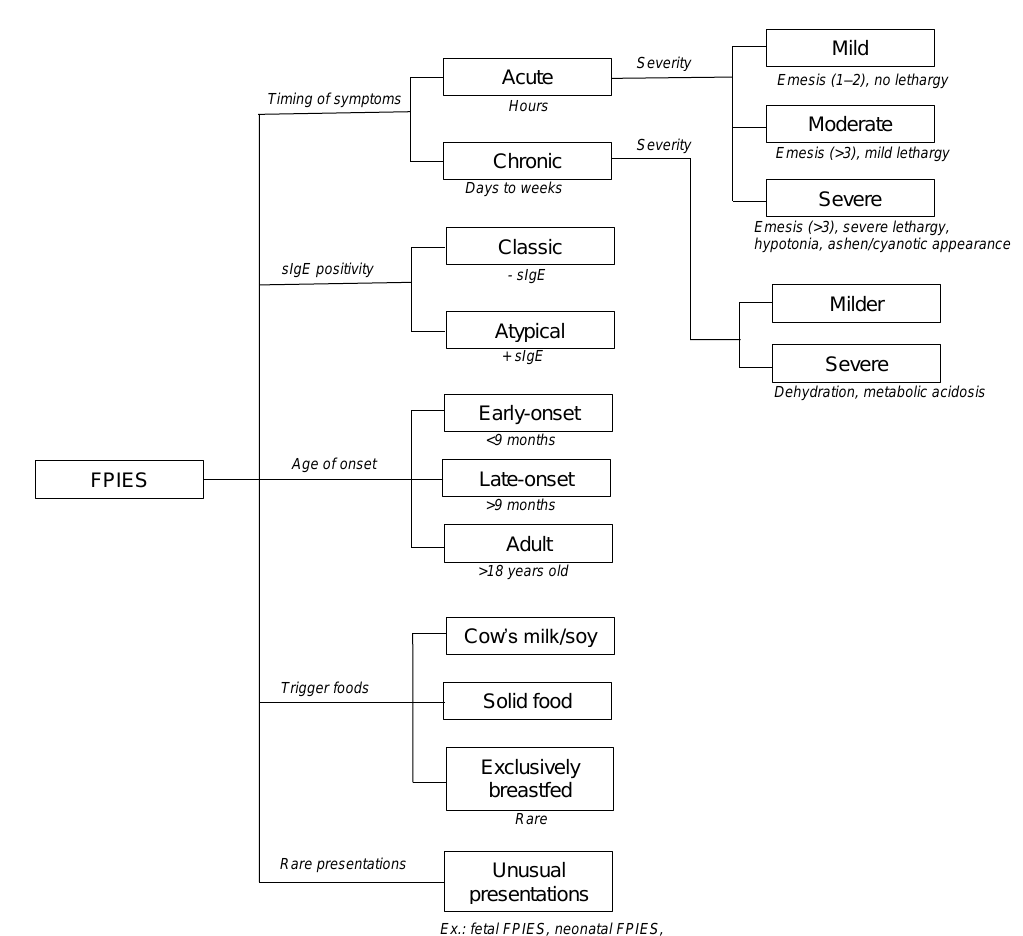
Figure 3. Classification scheme of FPIES. FPIES, food protein-induced enterocolitis syndrome; sIgE, food-specific immunoglobulin E; T21, trisomy 21 (Down